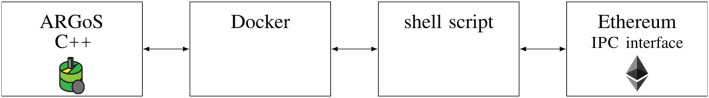
For each robot, the ARGoS-Blockchain interface establishes a connection to the Ethereum blockchain via a Docker container and shell scripts that provide templates for executing Ethereum (geth) functions.